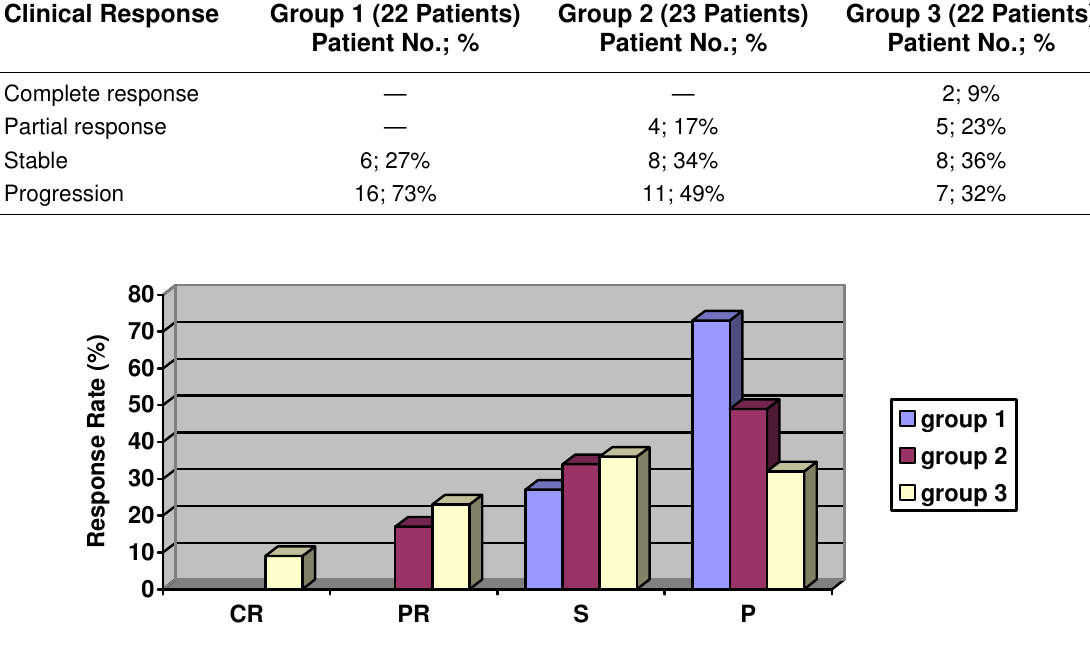
FIGURE 2 . The assessment of response according to the treatment groups at the end of 6 months (CR: complete response, PR: partial response, S: Stable, P: